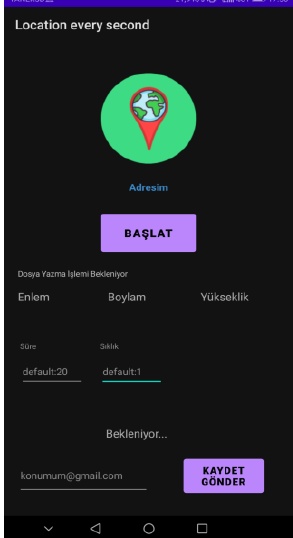
Figure 1 . The interface of the 'Location Every Second' Mobile